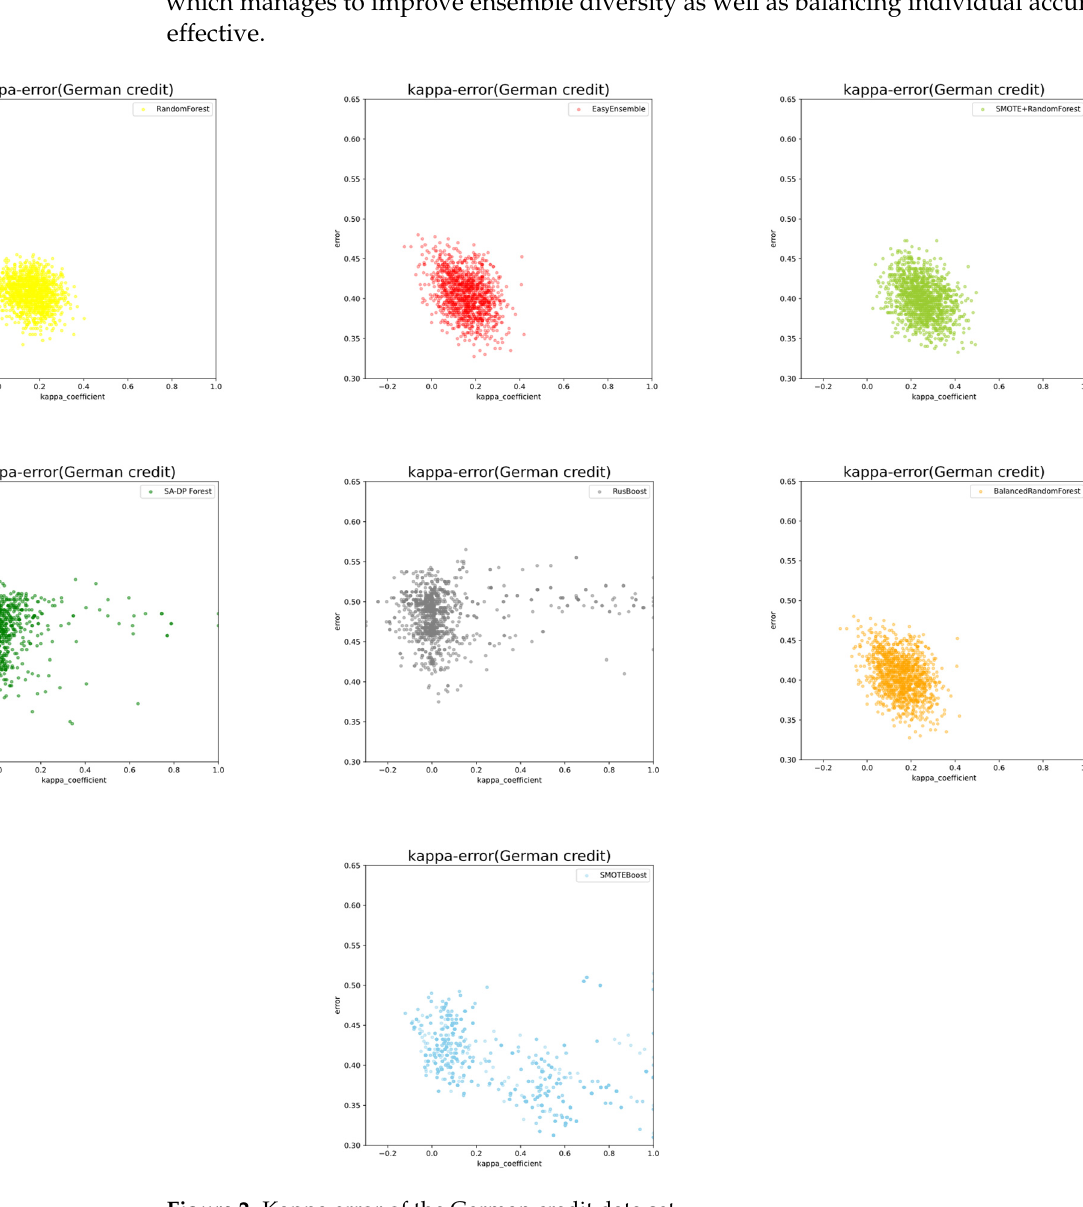
Figure 2. Kappa error of the German credit data